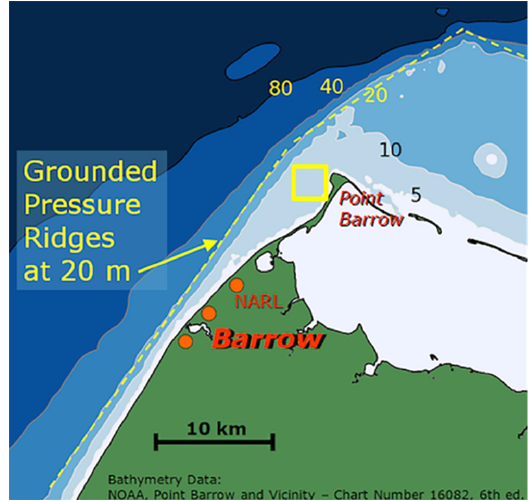
Figure 1. Map of Point Barrow area showing the location (yellow box) of the UAF sea-ice mass-balance site and permittivity mea- surements in spring 2013 and 2014. Contours represent bathymetry measured in meters. A grounded pressure ridge is located at approx- imately 20m water depth. The water depth at the mass-balance site is approximately